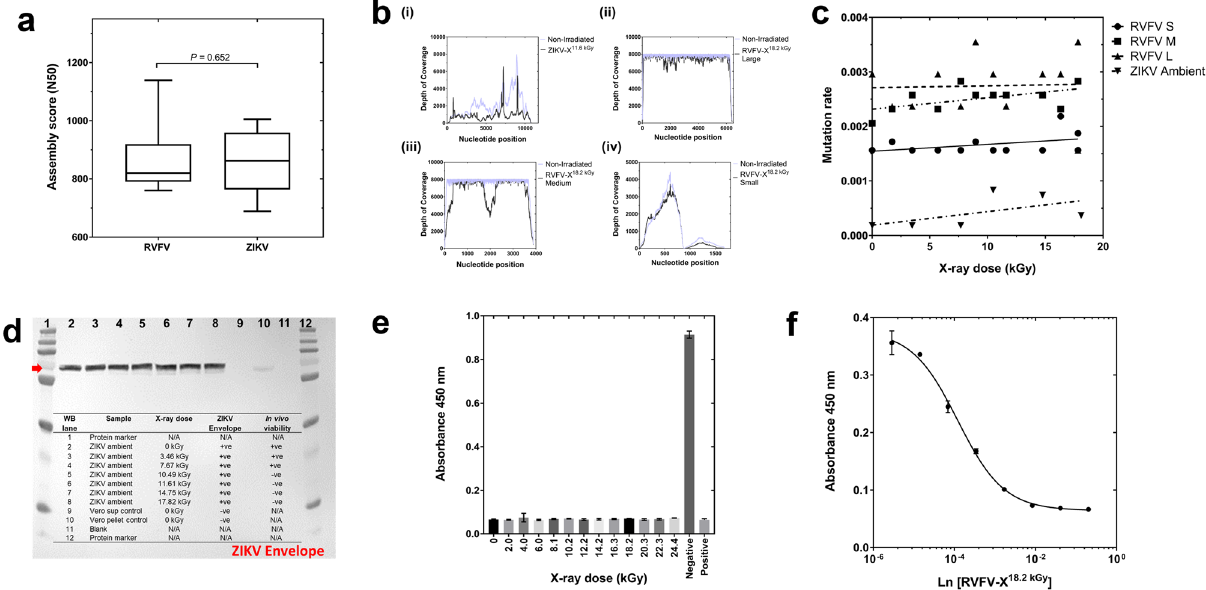
Figure 3. Nucleic acid and protein analysis of X-ray inactivated virus. (a) Box plot of N50 contig assembly statistics for RVFV and ZIKV, showing no statistical differences (Mann–Whitney U, two-sided) between viral contig re-assembly across radiation doses (0 to 24 kGy), (b) NGS mapping data demonstrating similar depth of coverage when comparing sequencing of non-irradiated and irradiated ZIKV-X and RVFV-X and (c) regression analysis of variants induced through X-ray irradiation across dose increments, showing non- significant correlations ( r 2 ≤ 0.32 ). The effect of irradiation on viral proteins by (d) Western blot detection of ZIKV envelope illustrating uniform sensitivity of detection, (e) abrogation of competition ELISA signal of RVFV anti-NP using X-ray irradiated antigen (n = 3 per dose). (f) two-fold serial dilutions of whole-virus RVFV irradiated with 18.2 kGy of X-rays inhibits the binding of anti-NP in commercially sourced competition